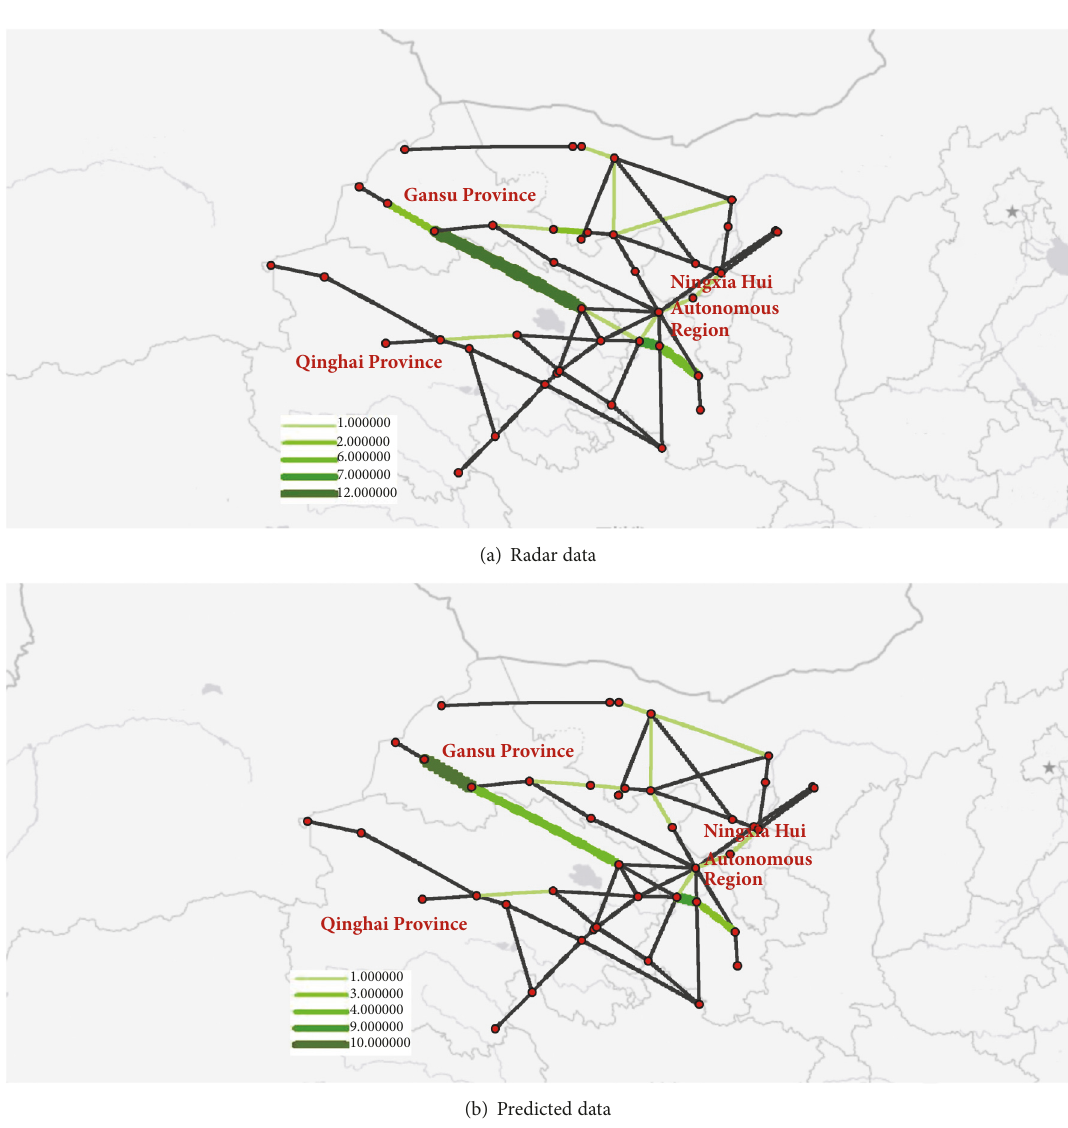
Figure 7: Flow distribution of the related flights at 12:00 on Lanzhou control